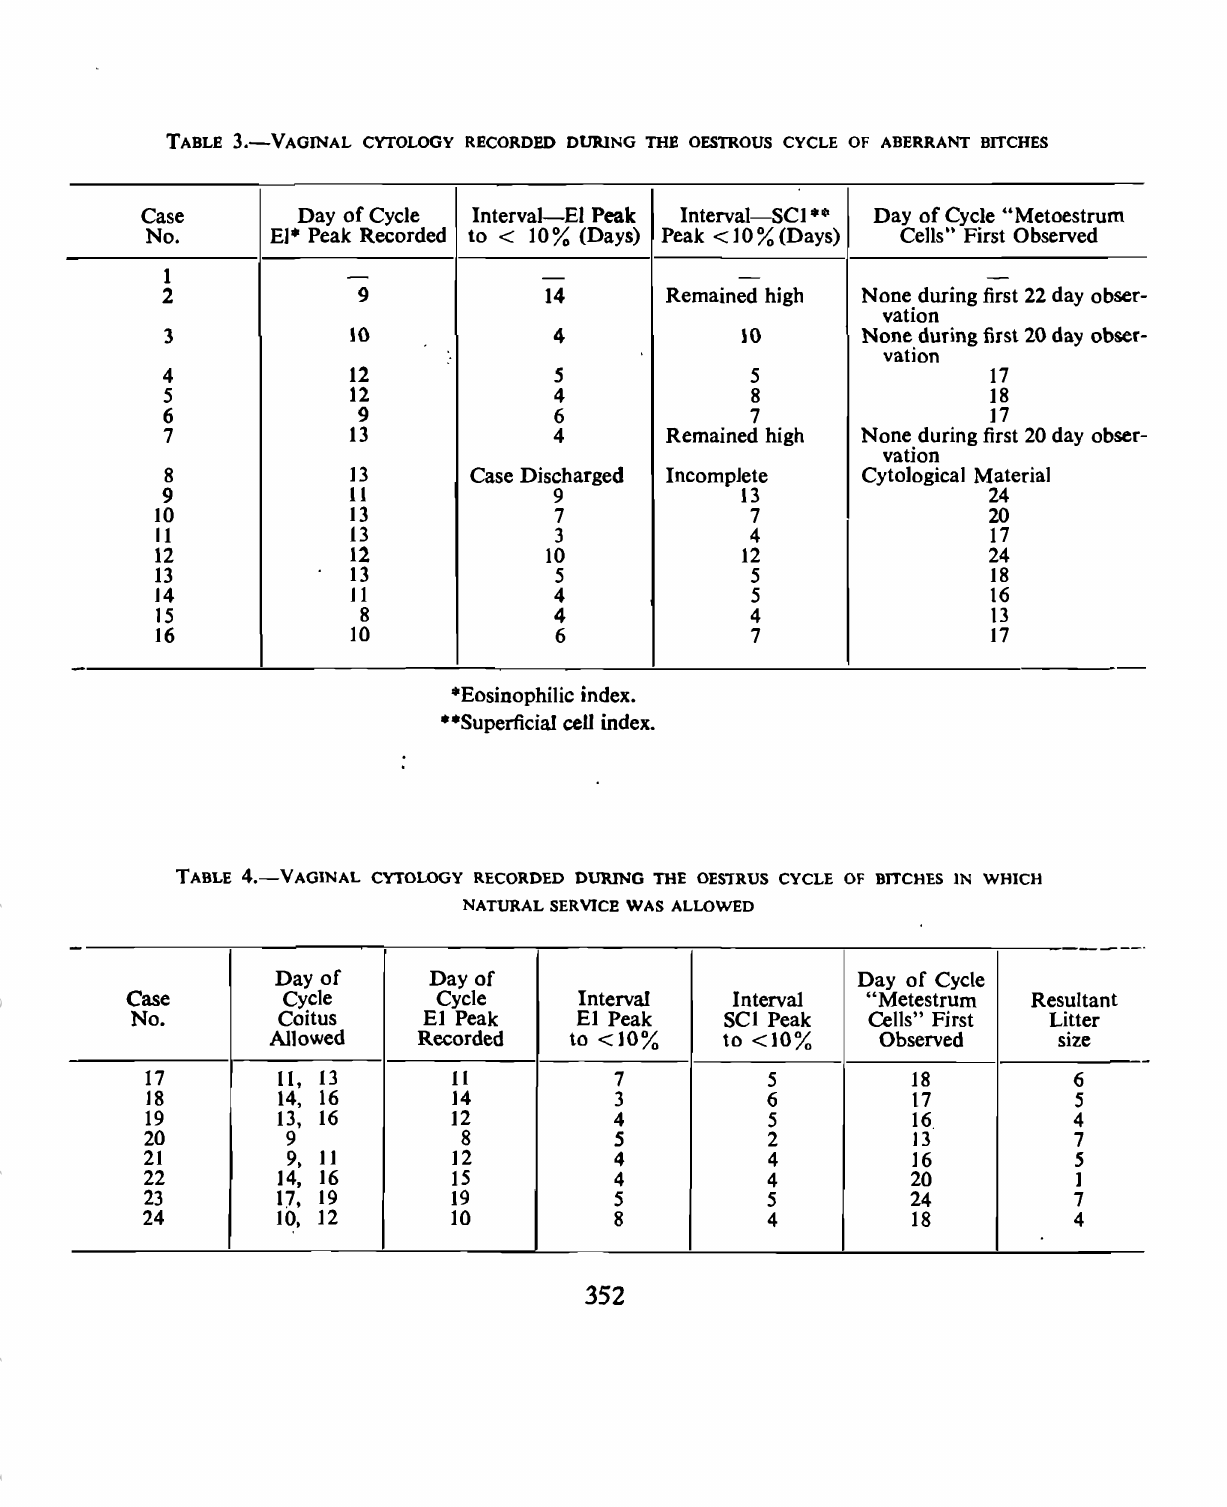
Case Day of Cycle Interval-EI Peak Interval-SCI" Day of Cycle "Metoestrum No.